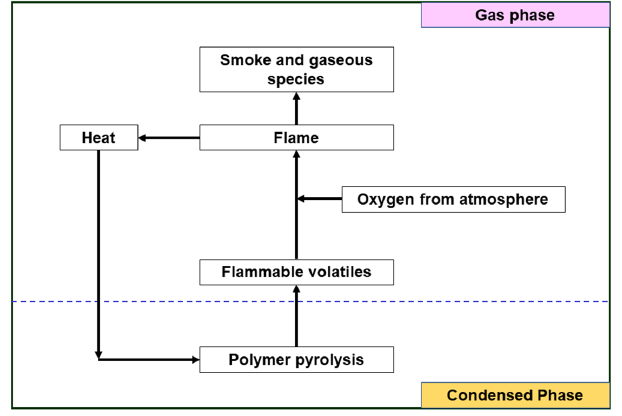
Figure 18. Potential modes of flame-retardant action in a self-sustaining polymer combustion cycle (Adapted from [145] under Creative Commons Attribution 4.0 International License).